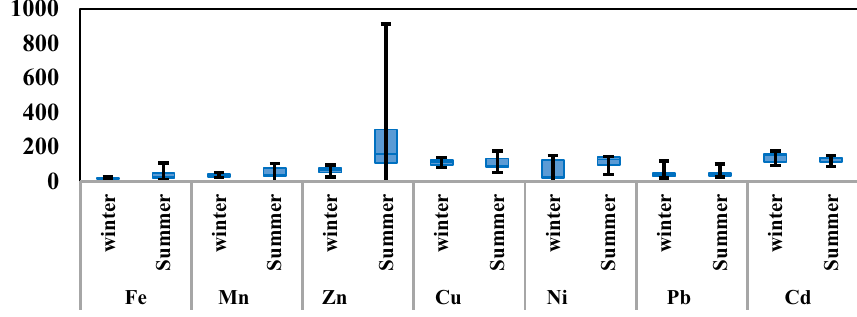
Fig. 4 Bioaccumulation factors of the measured heavy metals in muscles of Oreochromis niloticus collected from Mariout